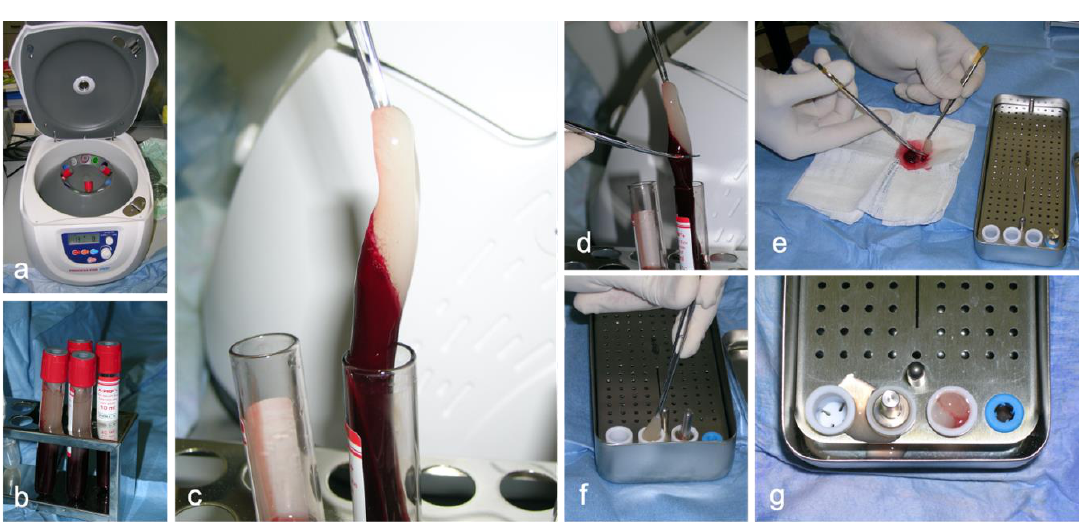
Figure 1. Platelet-rich fibrin preparation: ( a ) centrifugation of autologous whole blood using the specific DUO centrifuge; ( b ) Advanced PRF plus tubes immediately after centrifugation; ( c ) extraction of the PRF clot; ( d ) Coarse removal of the red blood cell layer; ( e ) careful isolation of the fibrin clot; ( f ) positioning of the fibrin clots in the specific wells of the PRF box; ( g ) squeezing of the fibrin clot using the metal piston to obtain a PRF plug from each well.